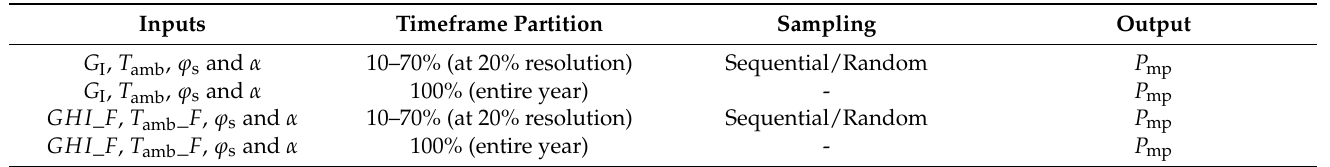
Table 2. Train set features, data timeframe partition, and sampling regime.